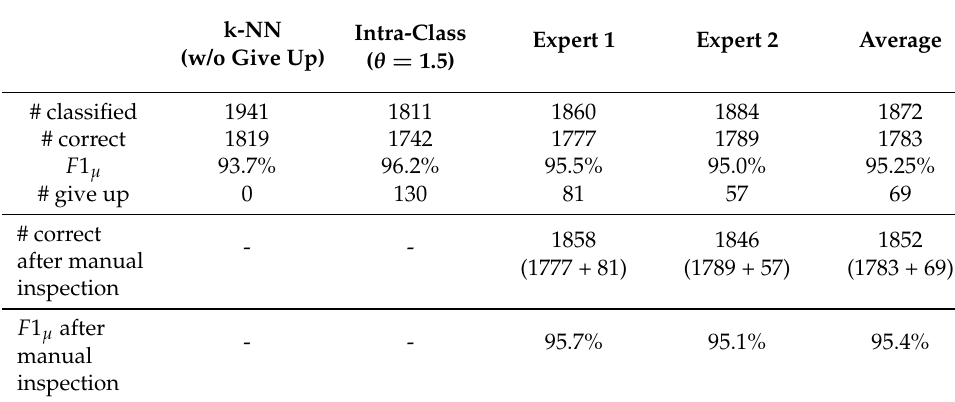
Table 4. Effectiveness of man-machine